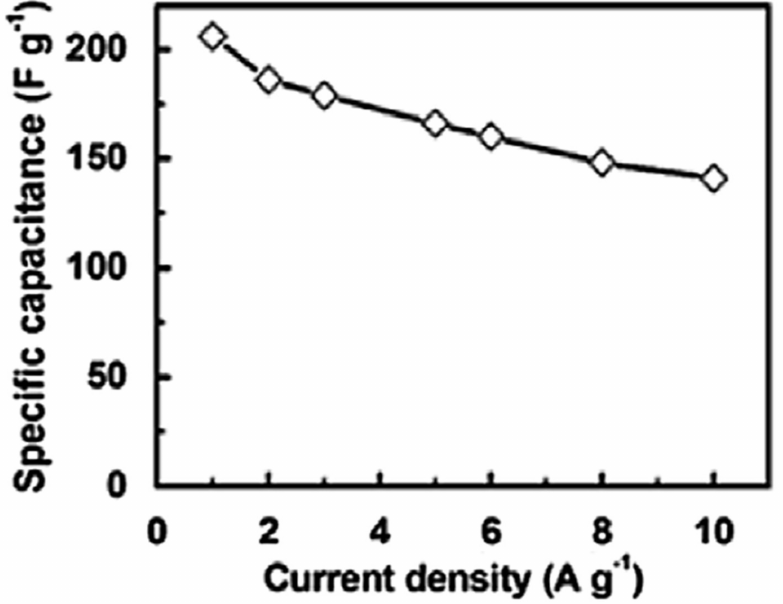
Figure 11. Specific capacitance vs. current density of graphene-nanofoam-based nanocomposite electrode. Reprinted with permission from Ref. [89]. 2014,